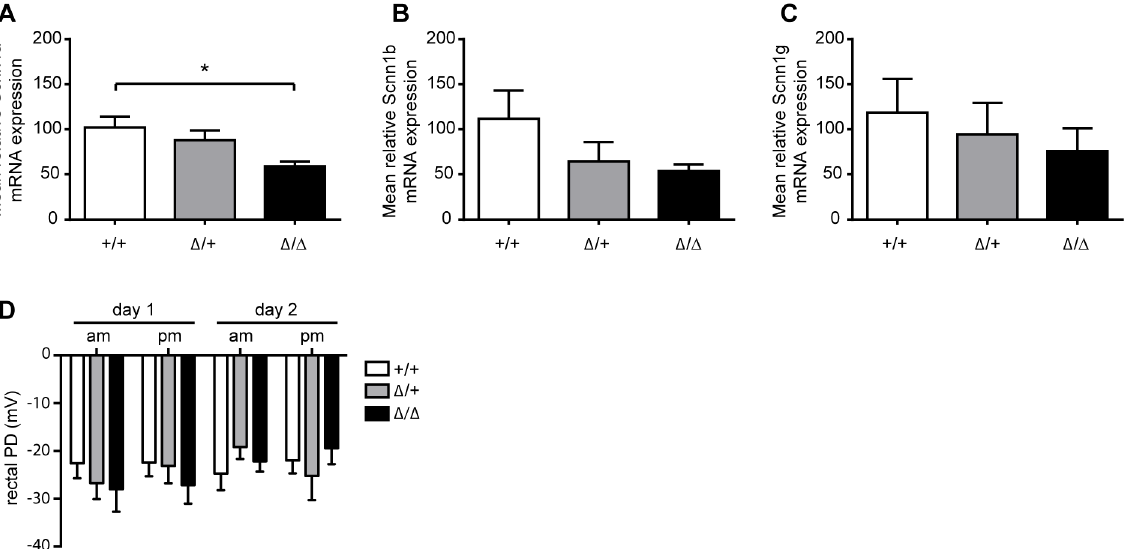
Fig 7. ENaC mRNA transcript expression and activity in colon from CAP2/ Tmprss4 mice under sodium-deficient diet. ( A-C ) Relative mRNA transcript expression of ( A ) Scnn1a , ( B ) Scnn1b and ( C) Scnn1g from CAP2/ Tmprss4 wildtype (WT, n = 4), heterozygous mutant (HET, n = 5), and knockout (KO, n = 4) mice; * P < 0.05); β -actin was used as internal control. ( D) Morning and afternoon amiloride-sensitive rectal potential difference (PD) measurements at 10-12am and 4-6pm of two consecutive days in Tmprss4 wildtype (WT), heterozygous mutant (HET) and knockout (KO) mice; n = 4 for each group and